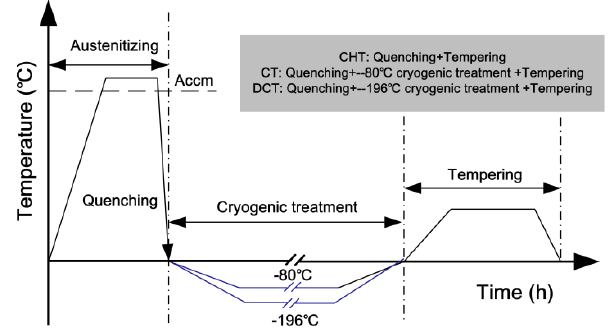
Figure 1. Heat treatment process.